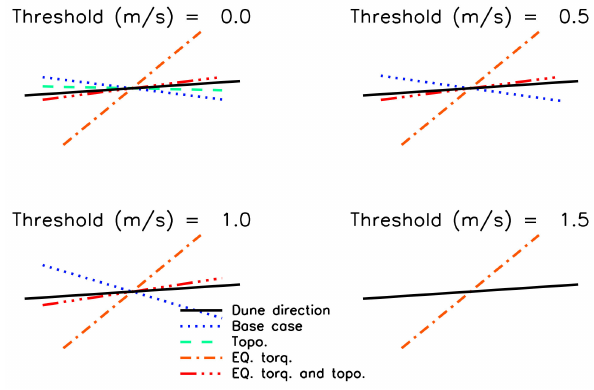
Figure 10. Average predicted dune bedform crestline orientations from our four simulations at the grid cells with dunes present along with the dune orientation direction. Similar to Figure 8, the north–south and east–west crestline vectors are averaged for each grid cell with dunes present, then the average bedform crestline is calculated. This indicates the mean direction of sediment transport. This figure indicates how well our average equatorial wind regime at dune locations matches the average dune alignment and how that changes as a function of saltation